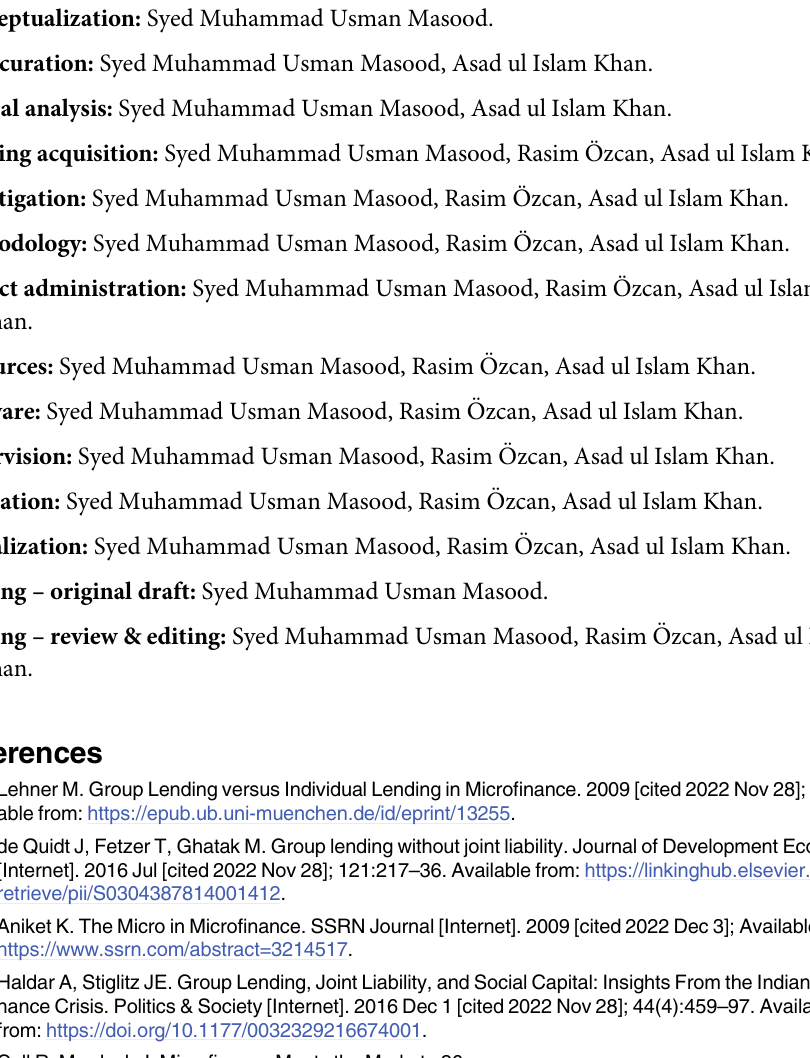
S1 Table. Summary statistics. S2 Table. First stage of